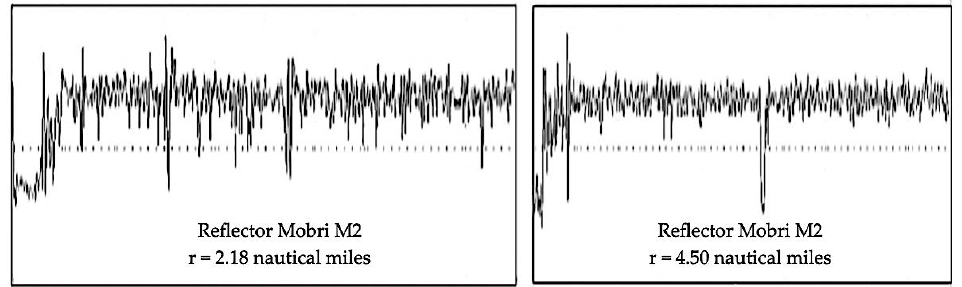
Figure 10. Oscillograms of the video signal of the Mobri M2 reflector, located at distances of 2.18 and 4.50 nautical miles from the radar antenna installed on the m/s TUCANA vessel.